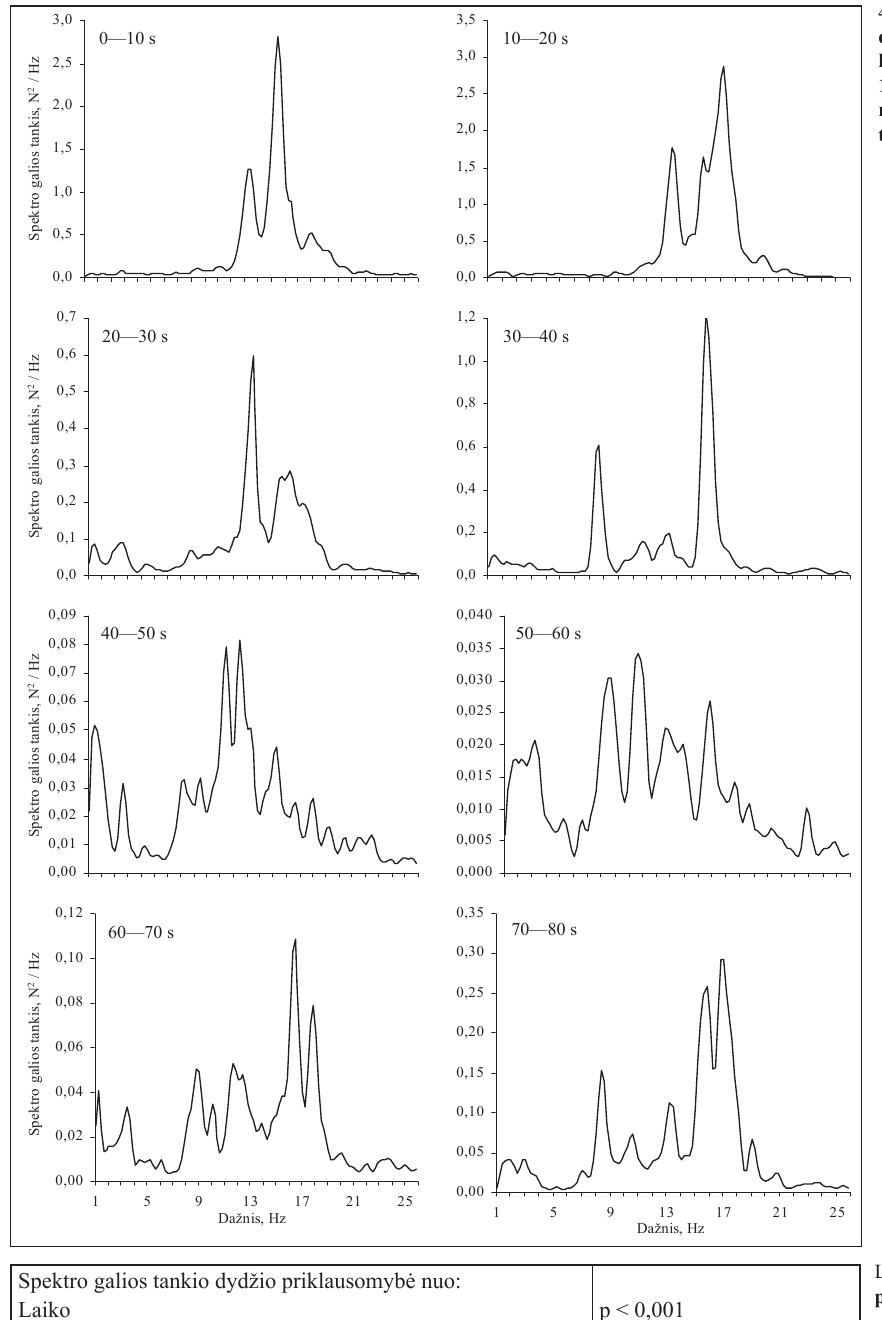
A. J. Sargeant (1987) nustat ė , kad pasyviai šildant kojas vandenyje vidin ė raumen ų (3 cm gy- lyje) temperat ū ra padid ė ja ~ 2,7 o C, o vienkartinio raumens susitraukimo j ė ga ir galingumas apyti- kriai padid ė ja 11%, ta č iau d ė l to grei č iau